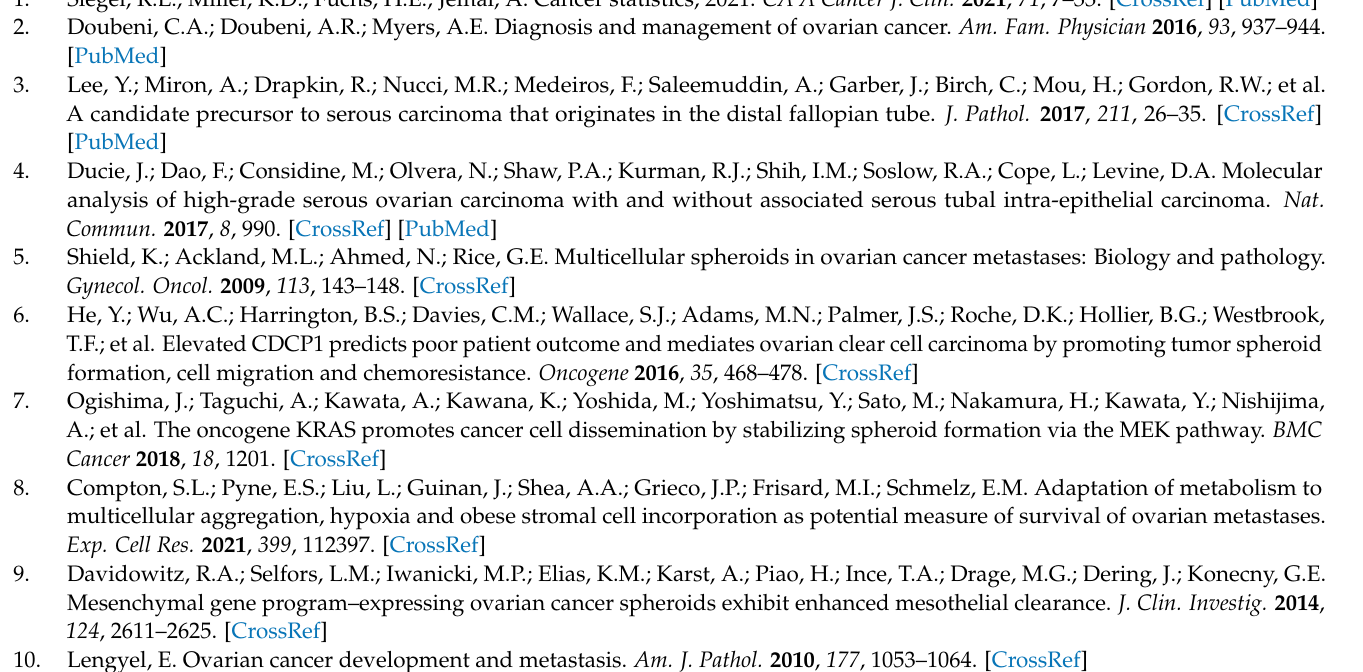
Figure S3: Outgrowth comparisons between control and S1P treatments for MOSE-L and MOSE- LTICv; Figure S4: Substrate oxidation of 14C-palmatic acid into CO 2 , 14C-glucose, and 14C-glutamine in HG HO and LG NO culture conditions; Figure S5: Substrate oxidation of 14C-palmitic acid into CO 2 , 14C-glucose, and 14C-glutamine in HG NO and LG HO culture conditions for S1P treated spheroids; Figure S6: Substrate oxidation of 14C-palmitic acid into CO 2 , 14C-glucose, and 14C- glutamine in HG HO and LG NO culture conditions for S1P treated